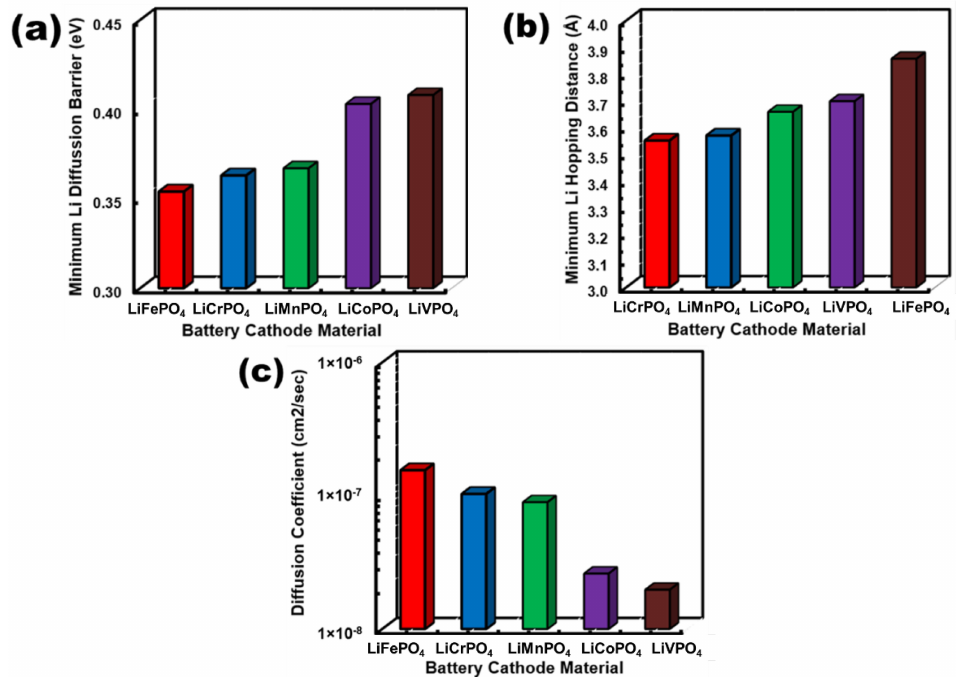
Figure 7. Comparative plots of ( a ) minimum activation barrier, ( b ) minimum hopping distance, and ( c ) intrinsic diffusion co-efficient for Li diffusion across Li channel (parallel to B-crystallographic axis) for different LiMPO 4 cathode